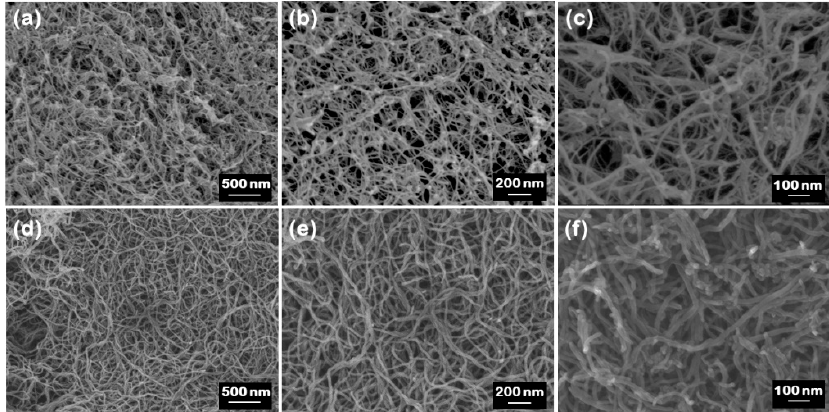
Figure 2. SEM images at different magnifications for ( a – c ) BNNTs and ( d – f ) CNTs.